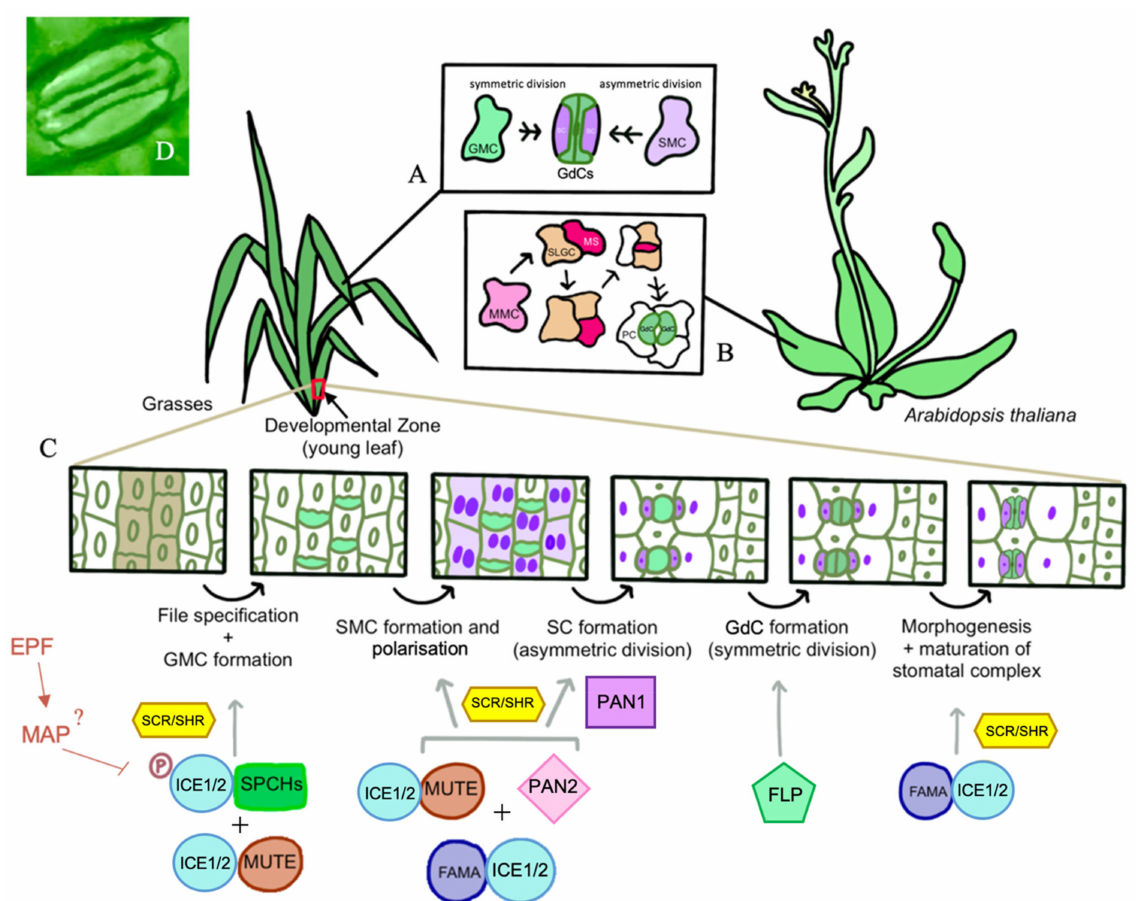
Figure 2. Illustration of pathway variability in stomatal development in Arabidopsis thaliana versus the grasses. In grasses, GMCs and subsidiary mother cells (SMCs) formed within two separate lineages associate to form mature stomatal complexes consisting of a guard cell pair flanked by subsidiary cells (SC) of perigenous origin ( A , D ). In Arabidopsis , a series of cell state transitions of the MMC leads to the formation of a guard cell complex with surrounding pavement cells (PC) of mesogenous origin ( B ). ( C ) shows the stages of mature stomatal complex formation in the grasses. ICE1/2 and the SPCHs have roles in stomatal file specification and selection of precursors for GMC formation. As in Arabidopsis , MUTE (in tandem with ICE1/2) modulates grass GMC formation. However, MUTE is also translocated from GMCs (light green cells) to adjacent cells to promote SMC formation and polarisation (large purple cells). PAN2 has roles in SMC asymmetric division by inducing function of PAN1 downstream, forming PCs (white with purple nuclei) and SCs (small purple cells). FLP acts to ensure appropriate orientation during symmetric division of GMCs into GdCs. FAMA and ICE1/2 activity is required for appropriate maturation of the stomatal complex. FAMA has additional roles in subsidiary cell formation. SCR and SHR operate in concert to regulate cell entry into the stomatal lineage, subsidiary cell formation, and stomatal complex maturation. EPF1 is predicted to negatively regulate ICE1 through a putative MAPK cascade; however, this requires experimental